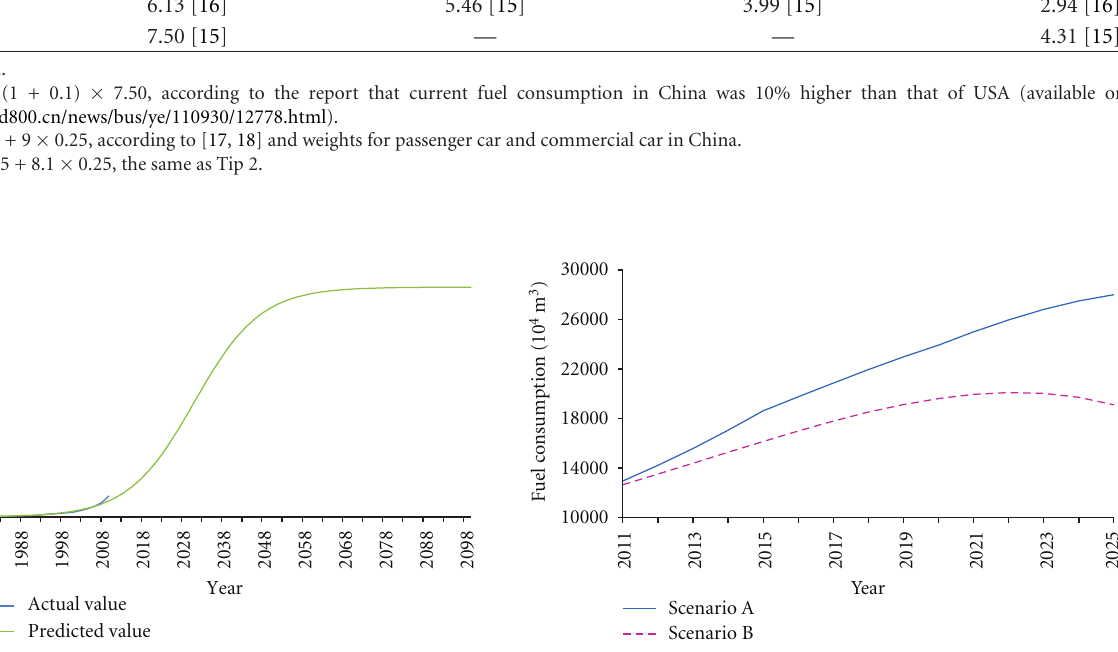
Figure 3: Prediction curve of future vehicle population in China. Figure 4: Forecast curve of China’s vehicle fuel consumption from 2011 to